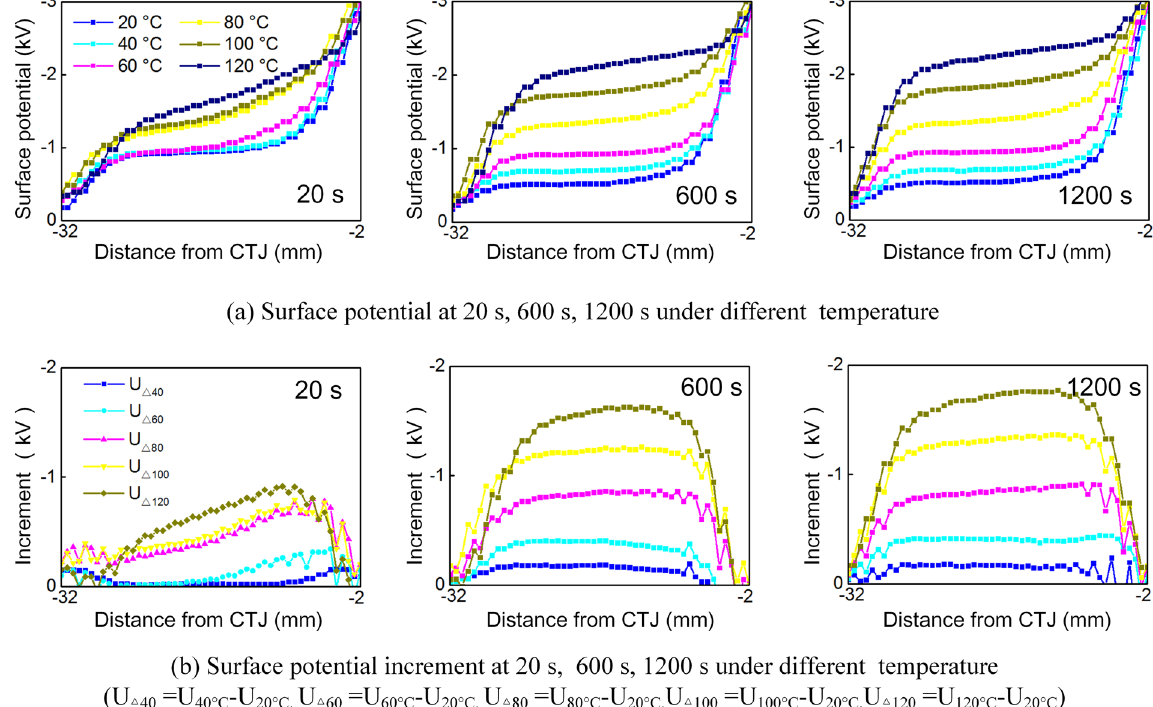
Figure 3. ( a ) Surface potential variation under different temperature gradient at different time duration and ( b ) surface potential increment under different